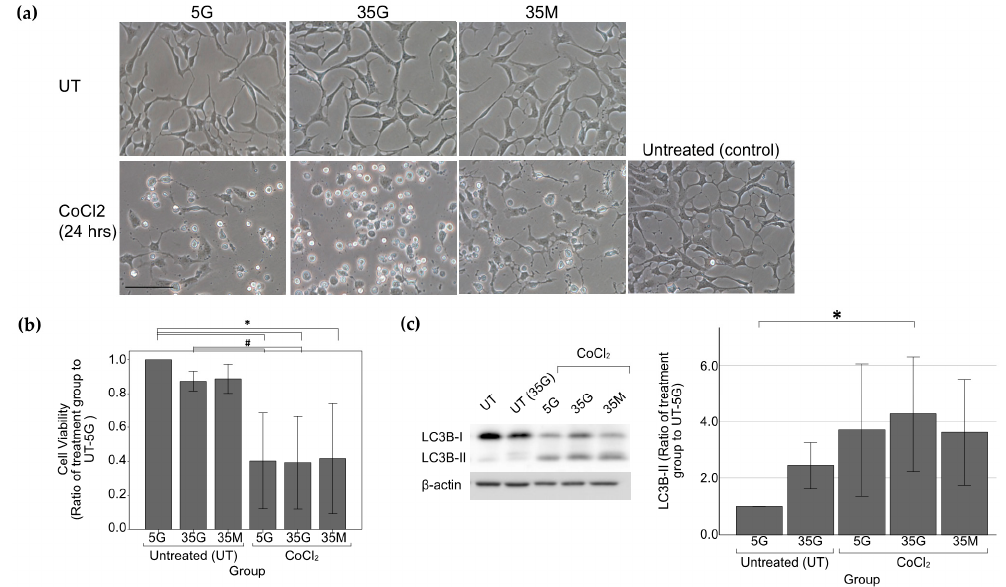
Figure 5. Cell morphology, cell viability and western blot analysis of LC3B-II in R28 cells under glucose treatment and/or 500 μ M CoCl 2 chemically-induced hypoxia. ( a ) Cell morphology of cells after glucose treatment alone and after 500 μ M CoCl 2 treatment. Similar cell morphology was observed among R28 cells subjected to different levels of glucose treatment and in the osmotic control. High glucose-treated cells appeared to be more susceptible to hypoxia damage as seen by the increase in cytoplasmic vacuoles. Scale bars: 100 μ m; ( b ) Cell viability of cells after glucose treatment and chemically- induced hypoxia. Both low glucose and high glucose-treated cells had significantly lower cell viability than their respective untreated groups. n = 7 except UT-35M n = 5. * p < 0.05 as compared with UT-5G, # p < 0.05 as compared with UT-35G. Values represent mean with error bars +/ − SD; ( c ) Western blot analysis of LC3B-II. Levels of autophagy markers LC3B-II were measured by Western blot analysis and normalized by β -actin. Densitometry analysis showed a statistically significant increase in LC3B-II levels in high glucose-treated cells subjected to hypoxia as compared with untreated cells. Glucose treatment alone (UT-35G) did not induce statistically significant LC3B-II upregulation. * p < 0.05 as compared with UT-5G. n = 7 except for UT-35G and 35M groups ( n = 4). Values represent mean with error bars +/ − SD. Figure and caption has been adapted from a dissertation [9]. Please refer to acknowledgements